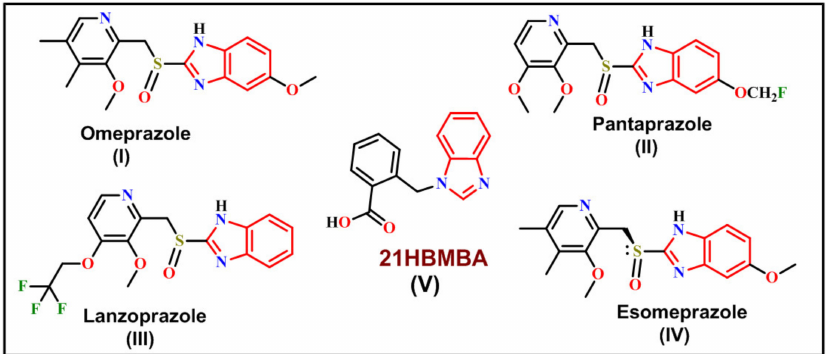
Figure 1. Some established benzimidazole derivatives as antiulcer agents in clinical practice. In the presence of formic acid, 1, 2-diaminobenzene can be converted to benzimidazole (Scheme